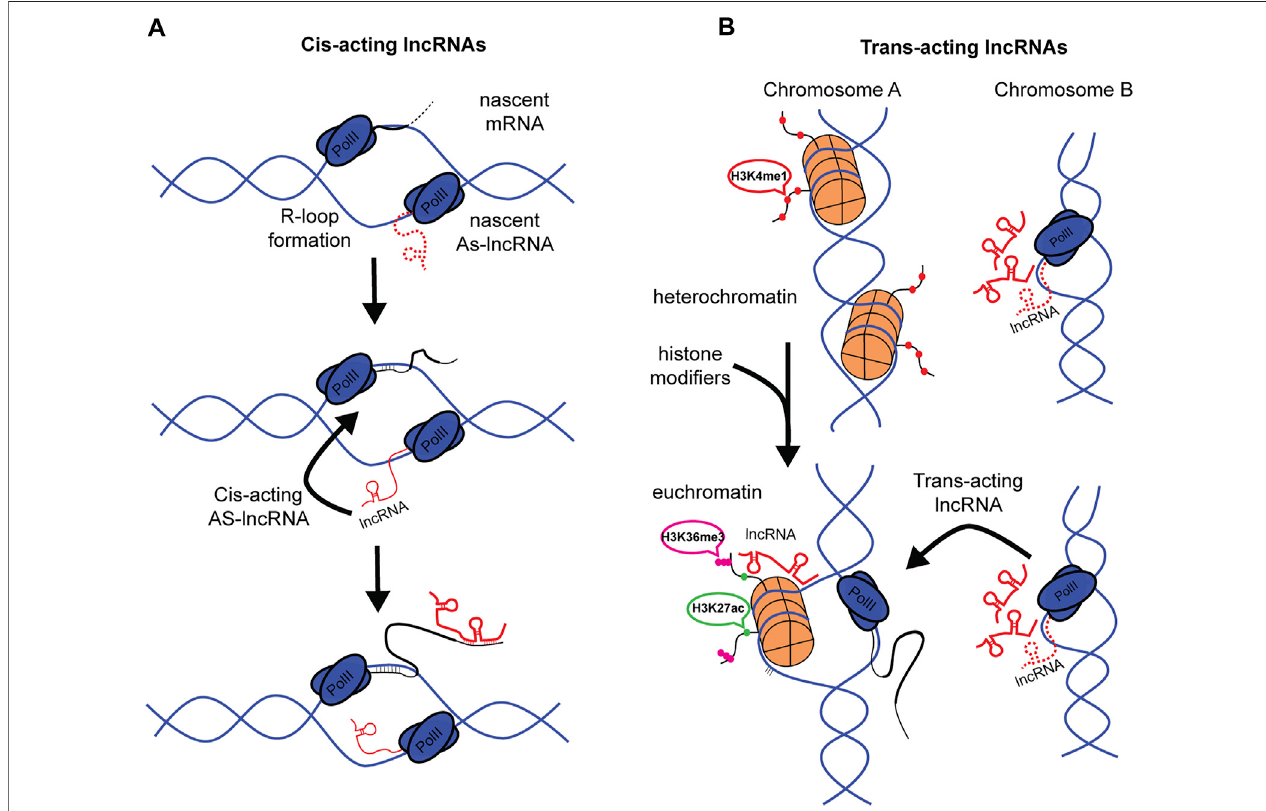
FIGURE 2 | Cis- and Trans-acting lncRNAs in m 6 A patterning. (A) Cis-acting lncRNA can be generated by bidirectional transcription via R-loop formation. AS- lncRNA can then bind directly with nascent mRNA. (B) Representation of Trans-acting lncRNAs. Histones are shown to be repressed in Chromosome A. Change in physiological state opens chromatin to facilitate gene expression, simultaneously, lncRNAs at Chromosome B are being transcribed. LncRNAs are then traf fi cked to Chromosome A to guide histone modi fi cations. (Red dots, H3K4me1. Green dots, H3K27ac. Magenta dots,